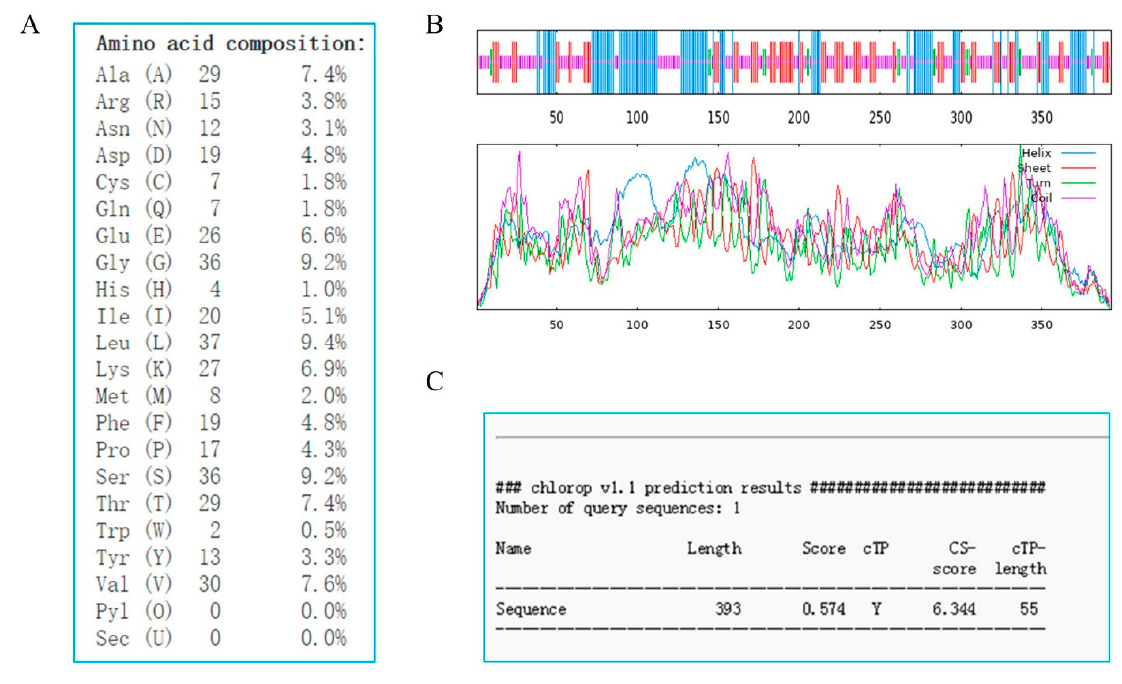
Figure 2. Sequence characteristics analysis of GhSBPase protein in upland cotton. ( A ) Analysis of the amino acid composition of GhSBPase protein. ( B ) Analysis of the secondary structure of GhSBPase protein. The blue, green, purple and red lines represent alpha helix, beta turn, random coil and extended strand respectively. ( C ) Prediction analysis of chloroplast transport peptide of GhSBPase protein.